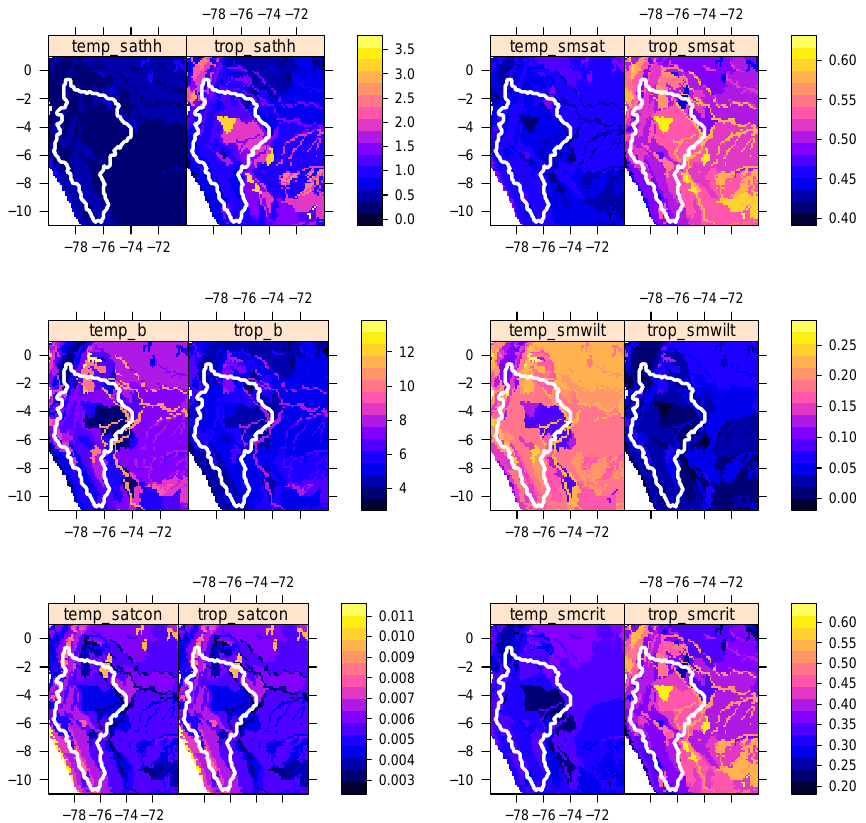
Fig. 10. Parameter variations generated using temperate (left panel) and tropical (right panel) pedotransfer functions in the topsoil (top 35cm). sathh: air entry pressure; b : Brooks and Corey exponent; smsat, smwilt, smcrit: volumetric soil moisture at saturation, wilting, and critical points. The hydraulic conductivity (satcon, mms − 1 ) is